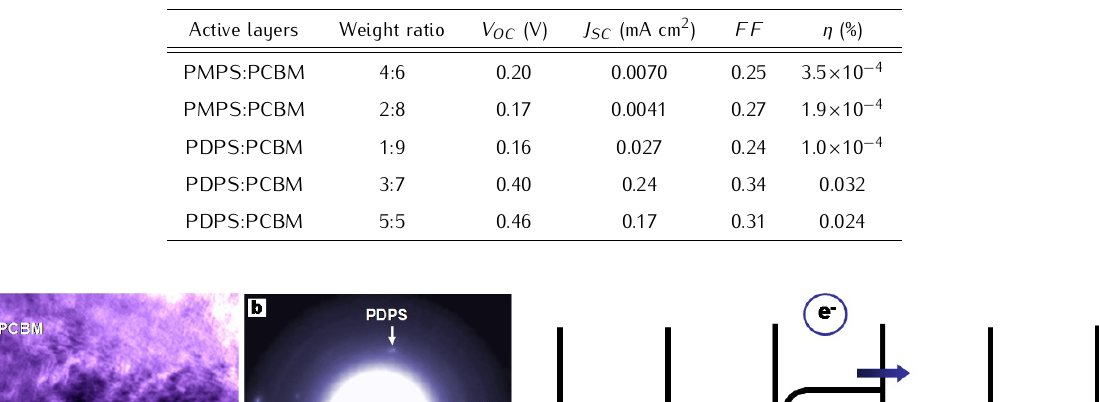
Table 1. Experimental parameters of polysilane:PCBM solar cells